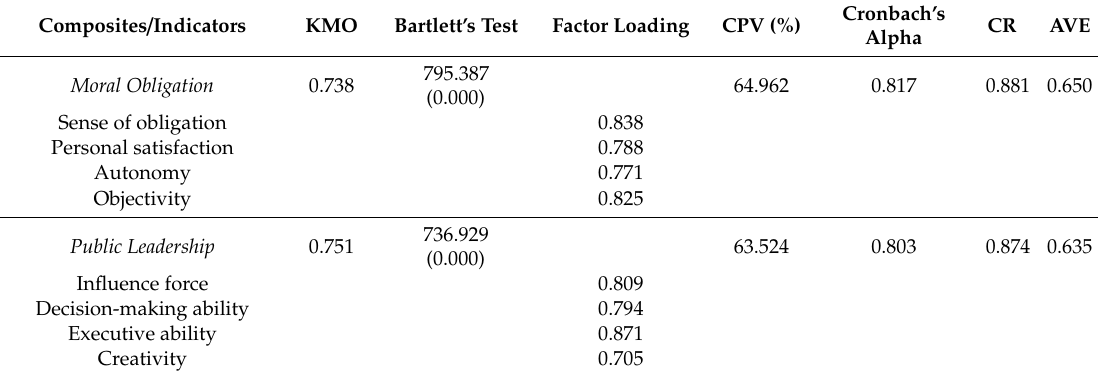
Table 2. Outcome of the reliability and validity analysis.